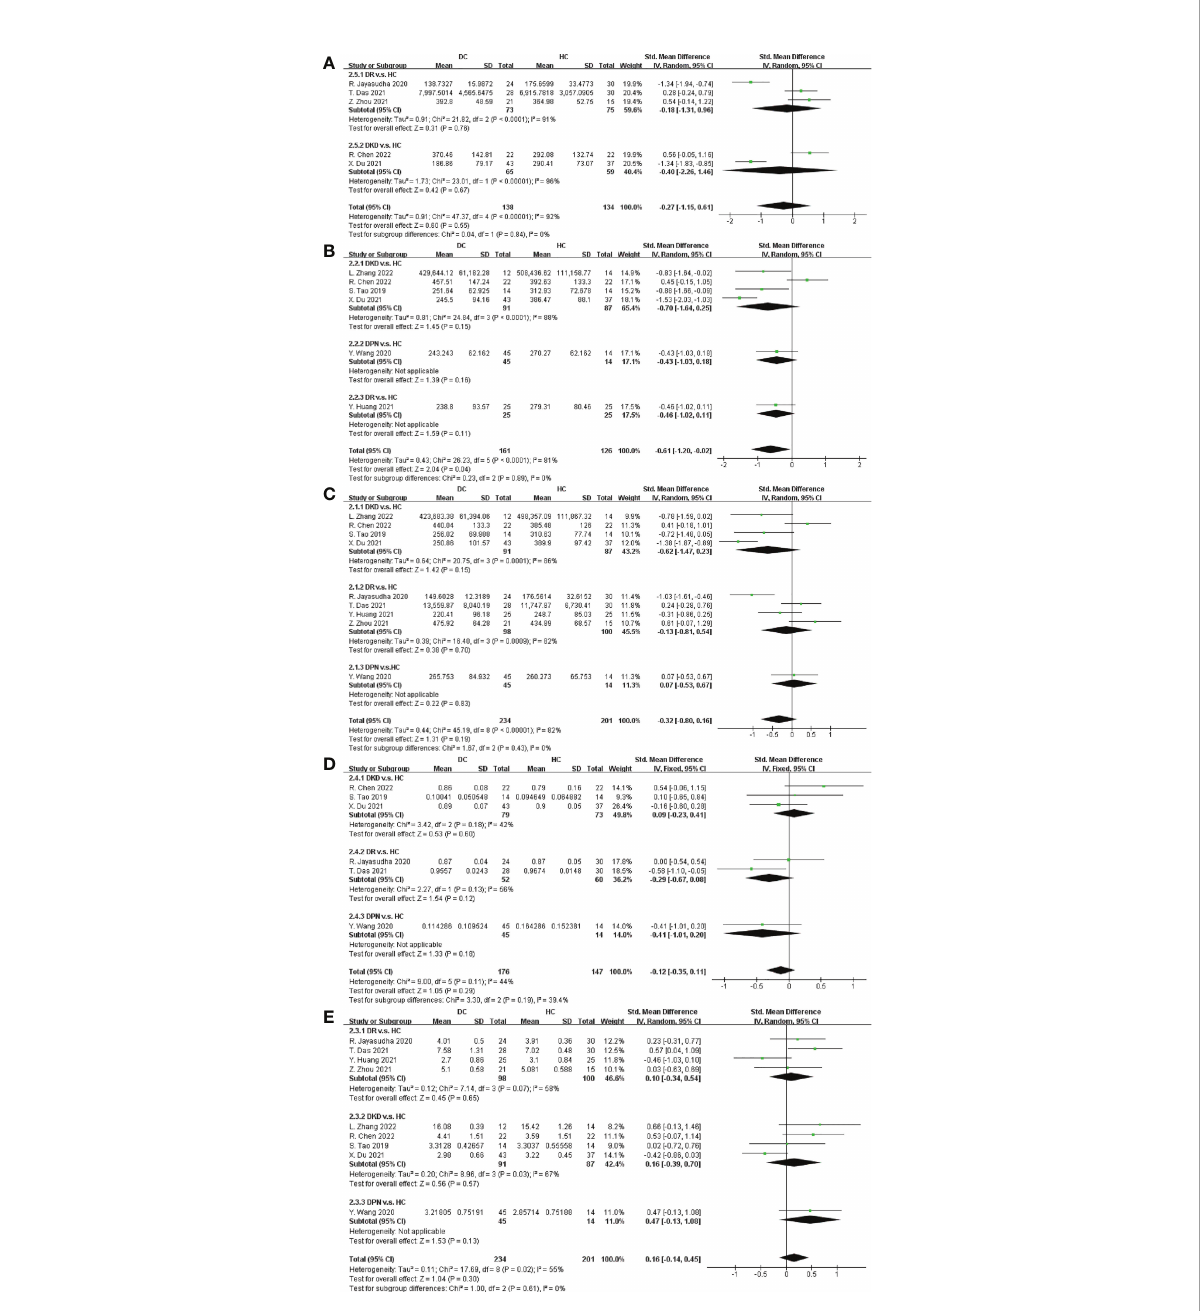
decreased in DC (SMD = -0.02, 95% CI[-0.02, -0.01], p <